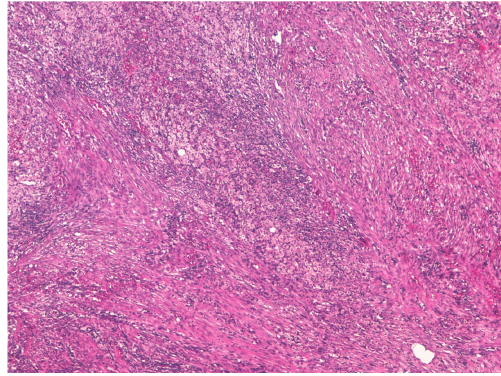
Figure 6: Colonies of Actinomyces species were founded in abscess areas, H&E